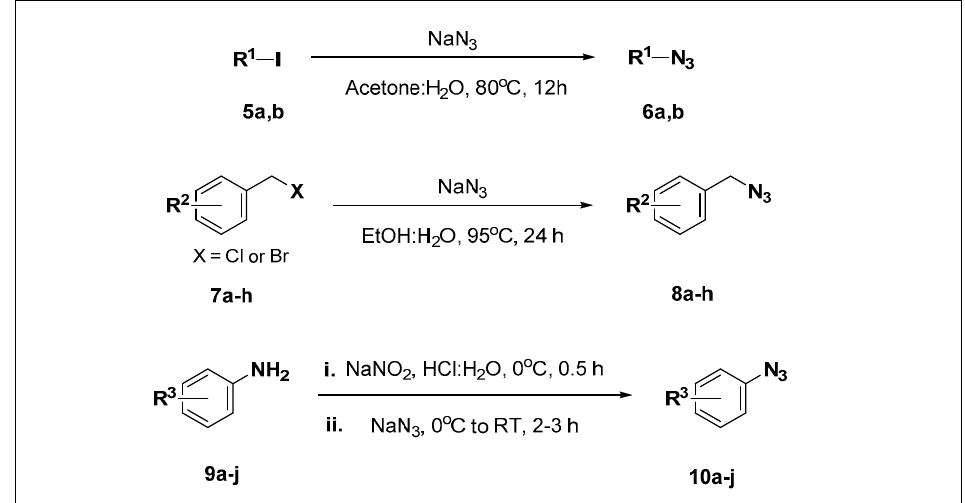
Scheme 2. Synthesis of requisite azide substrates for the 1,3-dipolar cycloaddition